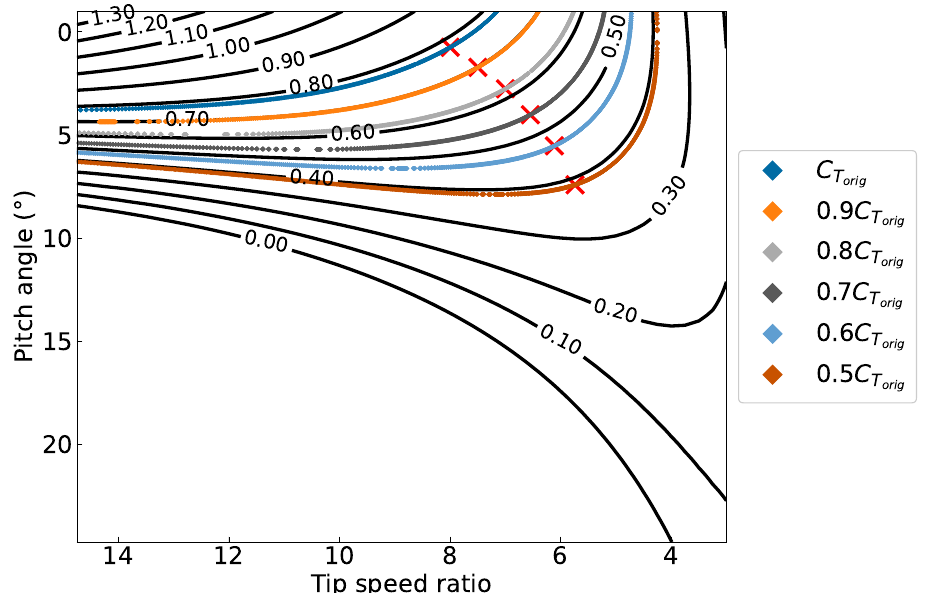
Figure 11. Contour plot of C T for the DTU 10 MW turbine. Each coloured line represents possible operating points for a given reduction in C T for Region 2b (with markers showing the optimal points).